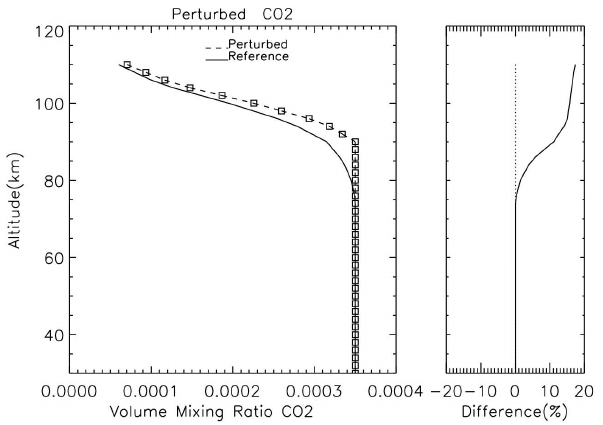
Fig. 18. CO 2 mixing ratio error. Right-hand panel shows the % error.